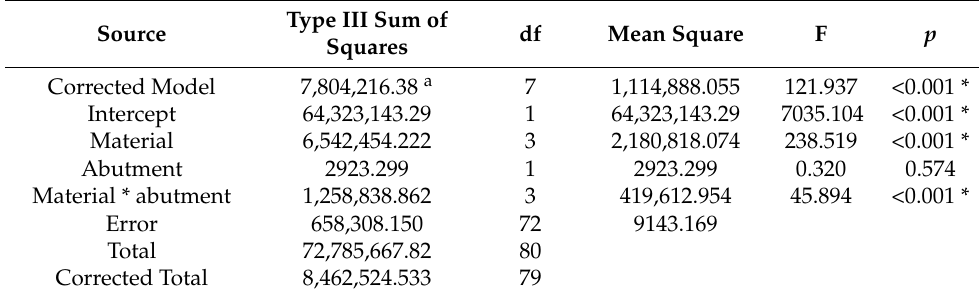
Figure 3. Means and standard deviations of fracture resistance. * Denotes significant differences at p < 0.05. LS, lithium disilicate; PICN, polymer-infiltrated-ceramic-network; RNC, resin nano ceramic; ZLS, zirconia-reinforced lithium silicate; TO, tooth abutment; TI, titanium abutment. Table 3. Results of two-way ANOVA.